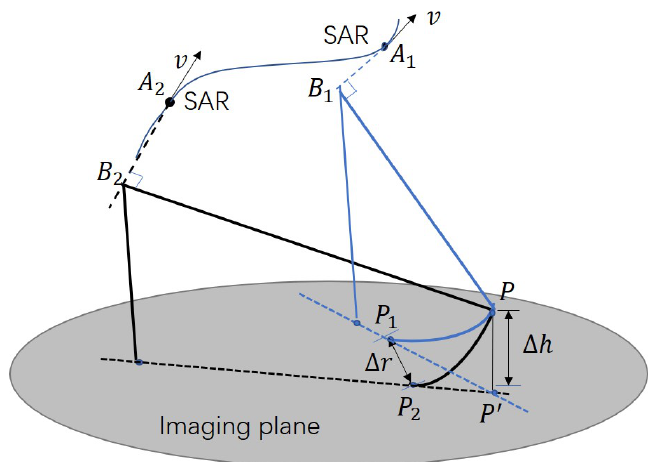
Figure 1. Geometric relation of multi-aspect airborne observation